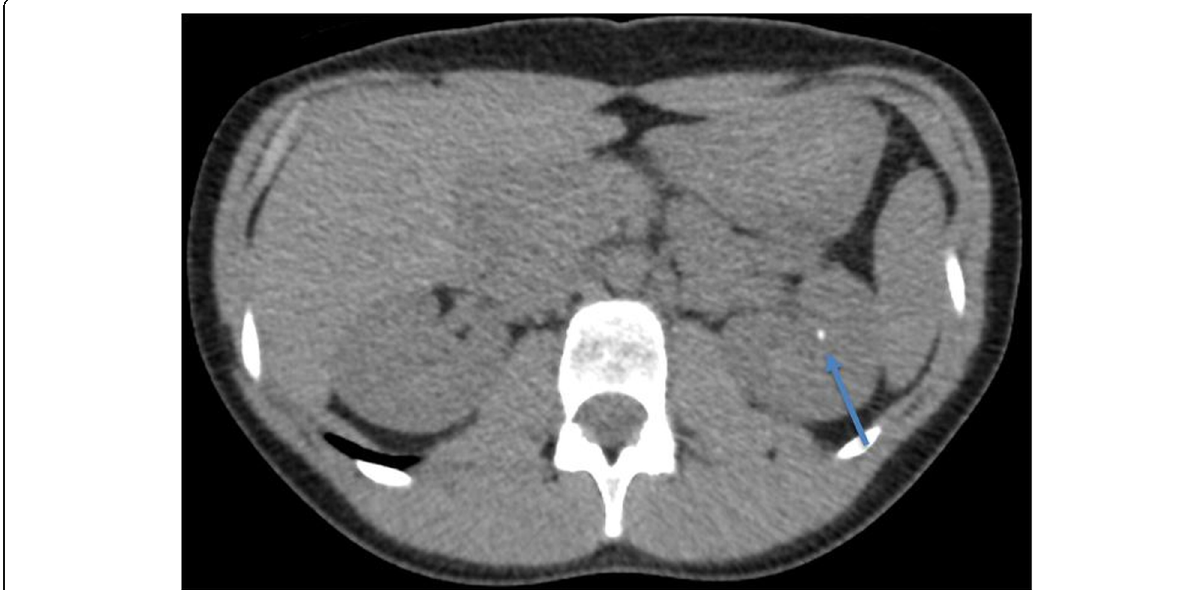
Fig. 3 Transverse abdomen CT image (kidney stone protocol) of a 17-year-old female (53 kg) acquired at 2.3 mGy. Left kidney stone (arrow) and overall image quality scored optimal by four-fifths of the readers and sub-optimal by one-fifths of the readers. However, a diagnosis of kidney stone was unaffected by all readers. Median IQSC score was